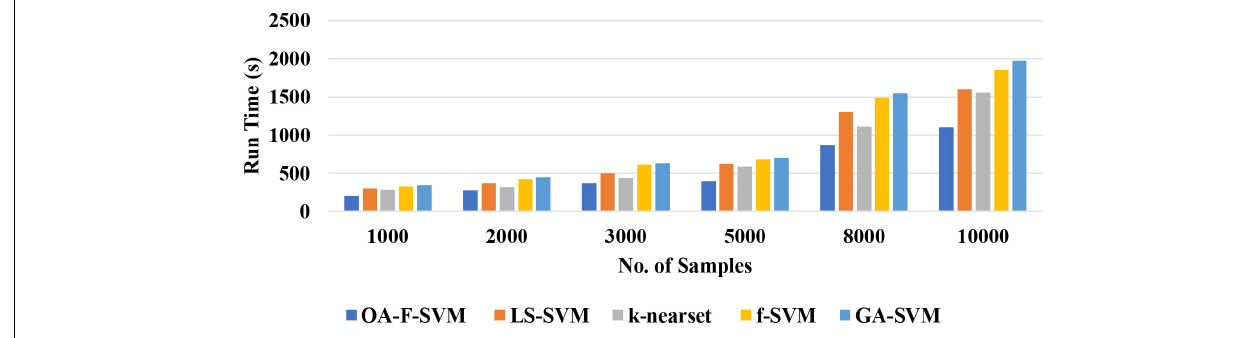
FIGURE 6 | A Comparison of run time among the proposed model with other.